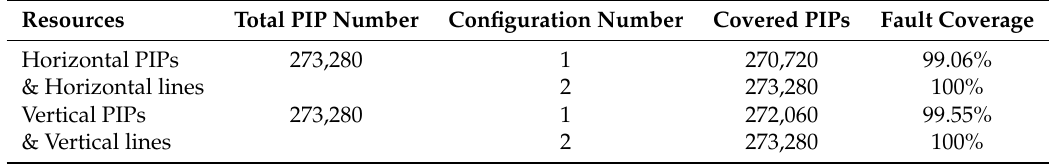
Table 2. Summary of the configuration number & fault coverage in the horizontal and vertical